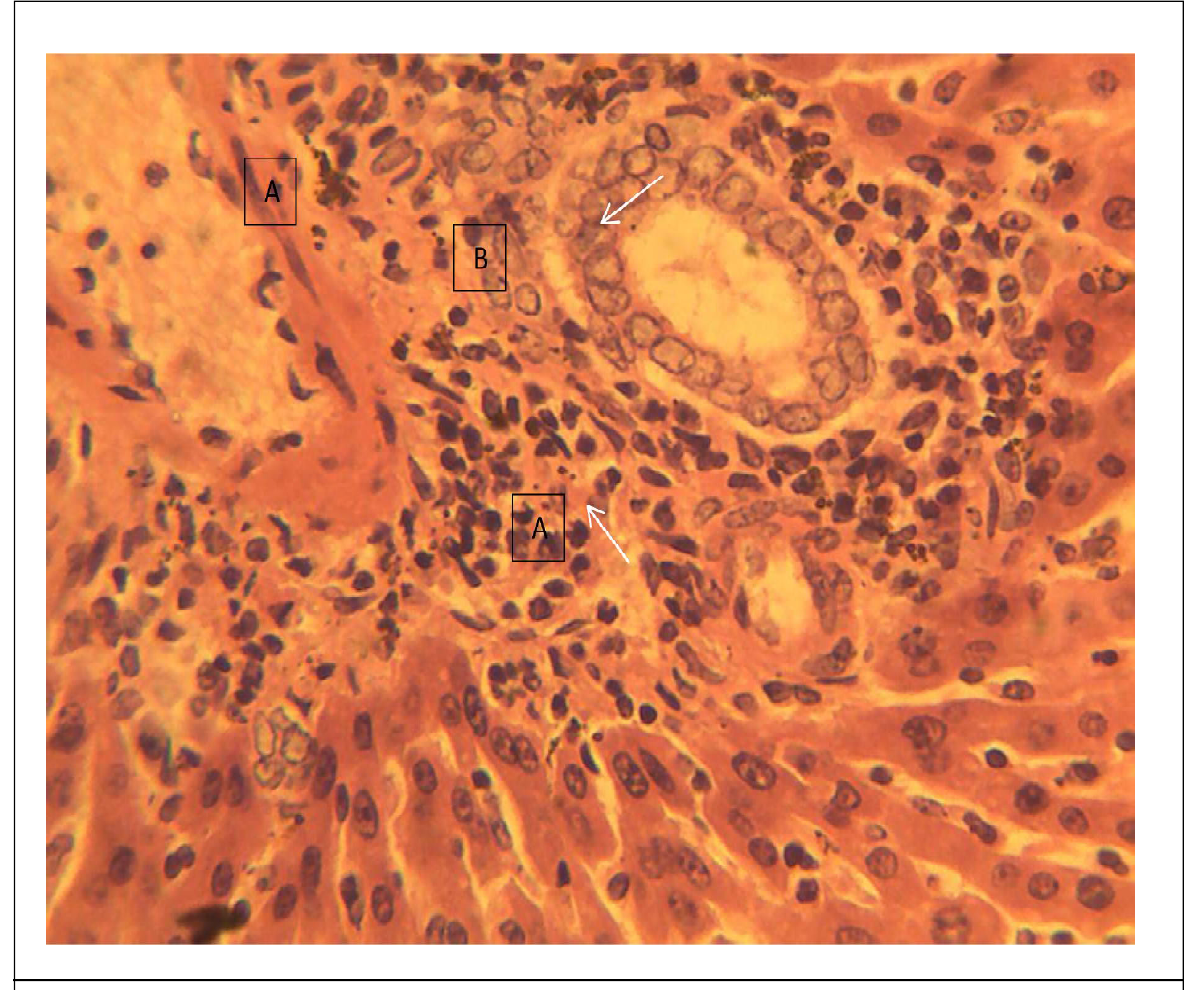
Plate 15: Female liver of the group exposed to 800 mg/kg of methanol extract